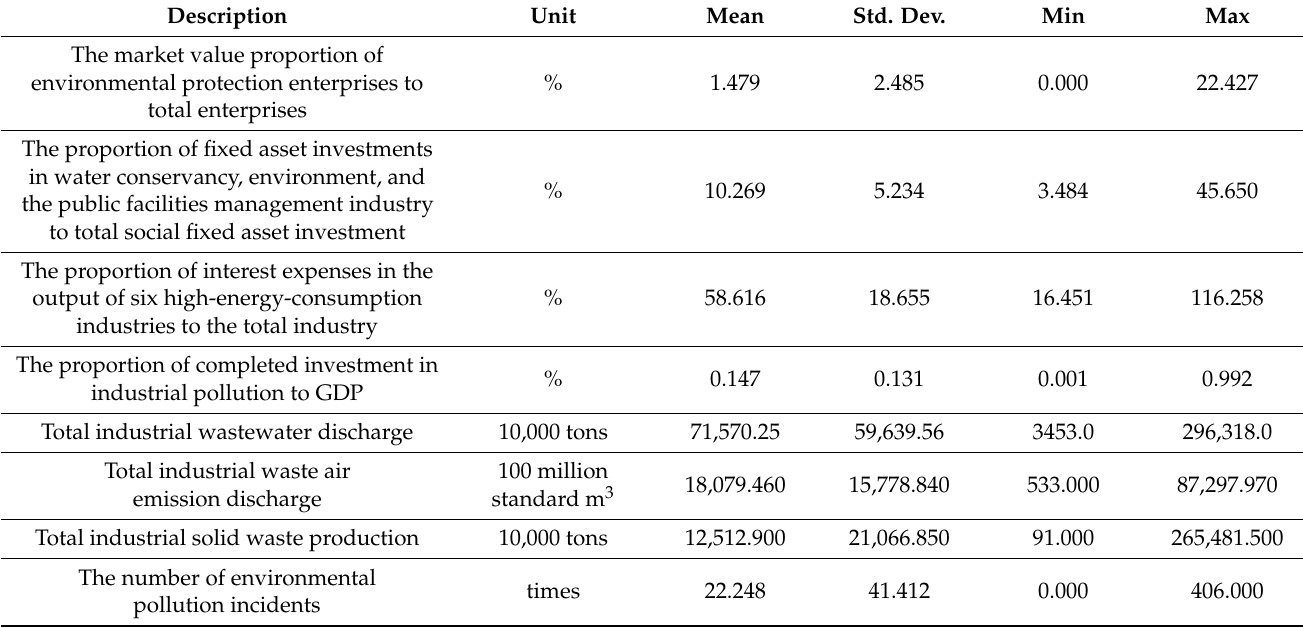
Table 1. Comprehensive appraisal index system and statistical descriptions.